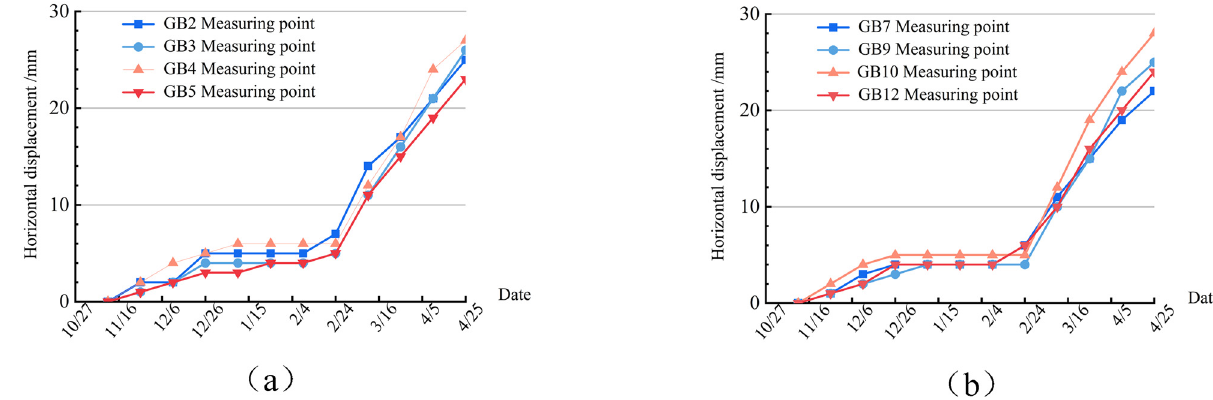
Figure 3: Horizontal displacement diagrams of the steel sheet pile top. ( a ) East side and ( b ) south